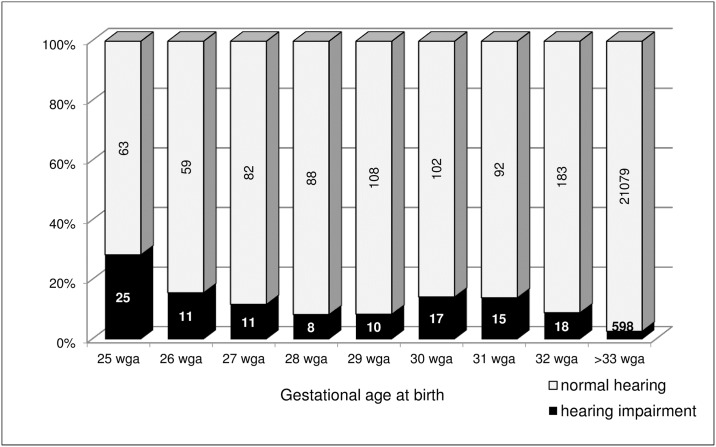
The prevalence of hearing impairment in relation to gestational age at birth.wga = week of gestational age at birth.